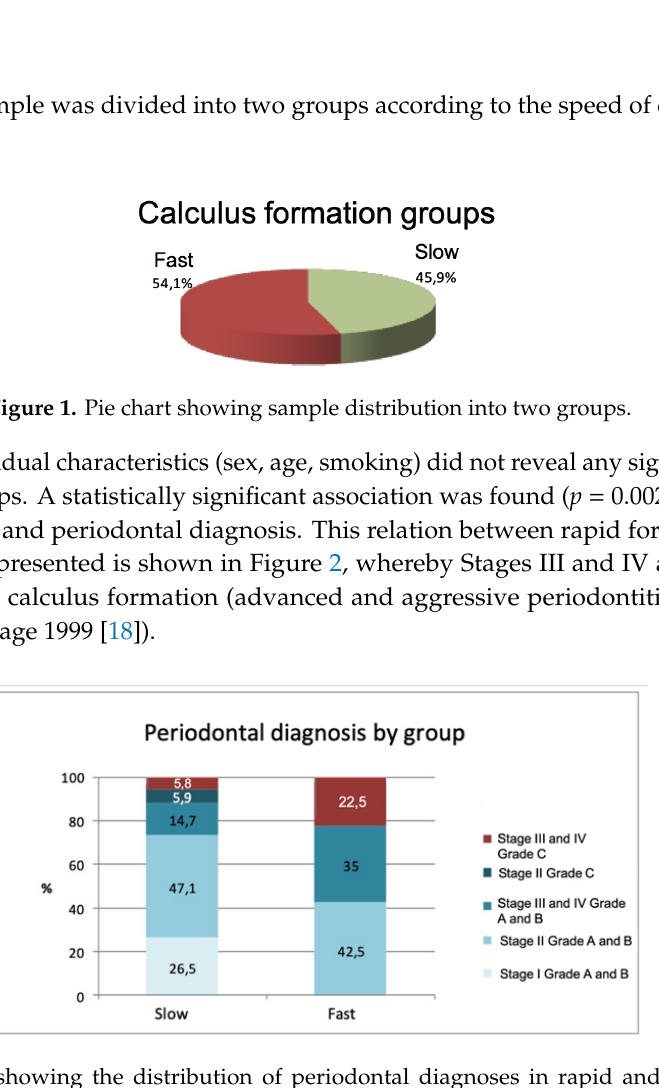
Figure 2. Graph showing the distribution of periodontal diagnoses in rapid and slow calculus formation